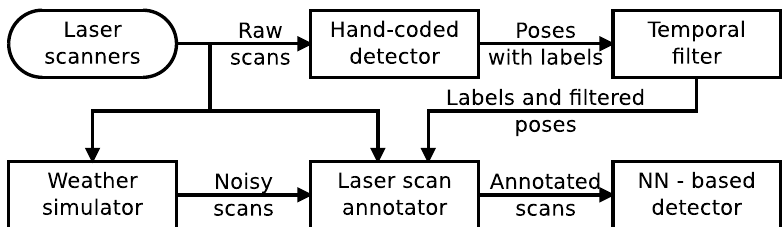
Figure 3. Conceptual model of our auto-labelling pipeline. The laser scans are passed to a clustering- based hand-engineered object detector, whose detections are then corrected through an offline temporal filter. Simultaneously, the laser scans are altered through the weather simulation step. Should the object no longer be detectable in the laser scan due to the weather alterations, or even outright failed to have been detected but was at other time periods, the pipeline can still provide training labels for the current scene to the neural network, allowing it to be trained without human annotation